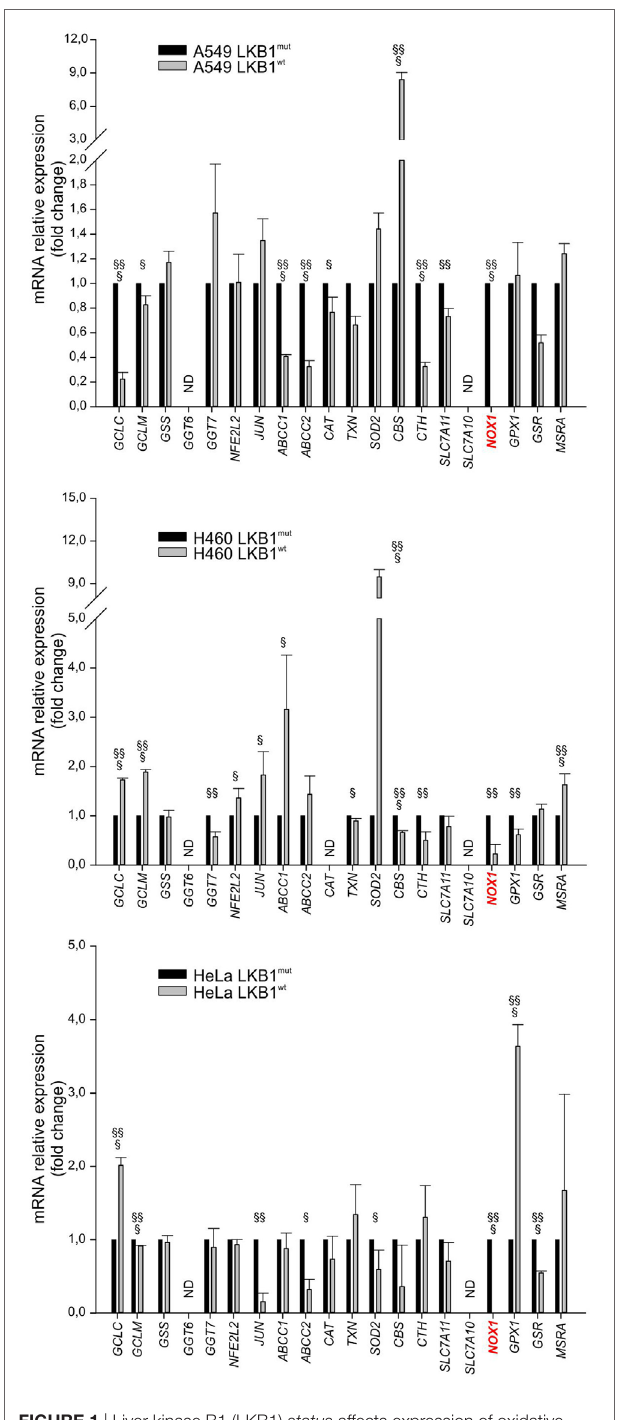
FigUre 1 | Liver kinase B1 (LKB1) status affects expression of oxidative metabolism-related genes. Expression profile of selected genes in isogenic pairs of A549 (top), H460 (middle), and HeLa (bottom) cells. Transcription levels of each gene were quantified by real-time Ready Custom Panels and normalized to HMBS mRNA content. Results are reported as mean value ± SD of three independent experiments and are expressed as fold change with respect to LKB1 mut cells, arbitrary set as 1 for each analyzed transcript ( § P < 0.05, §§ P < 0.01, §§§ P < 0.001). ND = expression level not